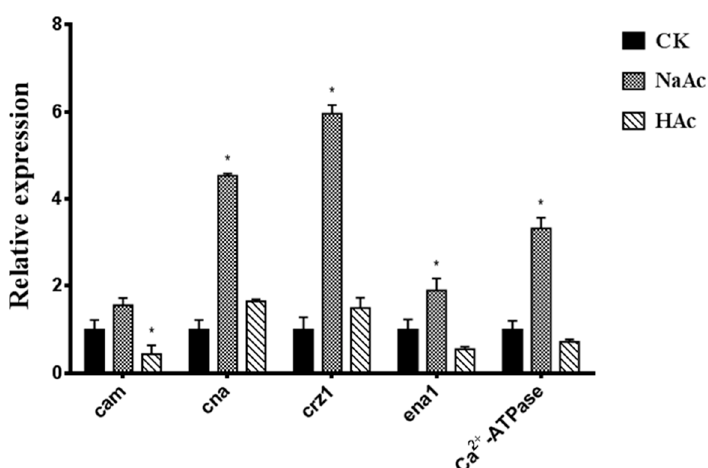
Figure 7. Transcriptional levels of calcineurin signal pathway genes in the CK strain and the treatment group. The expression level of the samples from the CK strain is defined as 1.0, and the expression levels in the treatment group strain are displayed in relation to the reference sample. The error bars indicate the standard deviations from three independent samples. * indicates statistical significance ( p < 0.05) compared to the CK strain. CK, control check; HAc, acetic acid; NaAc, sodium acetate; cam , calmodulin; cna , calcineurin subunit A; crz1 , calcineurin-responsive zinc finger; ena1 , encoding Na + -ATPase.